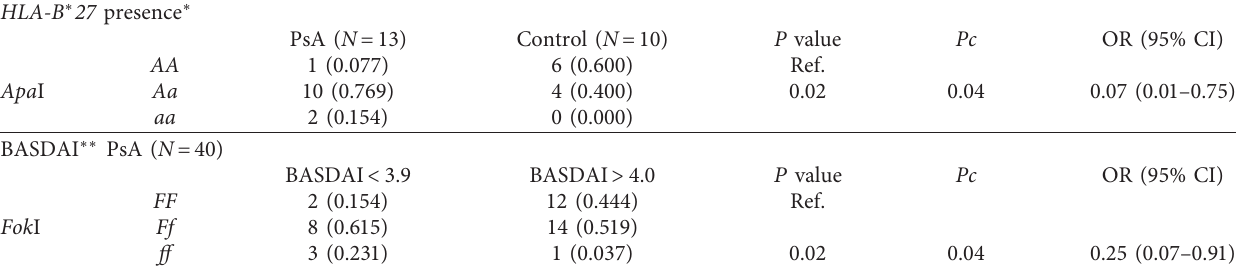
Table 5: Association between Apa I and Fok I genotypes with psoriatic arthritis (PsA) classified according to the HLA-B ∗ 27 presence and the BASDAI.